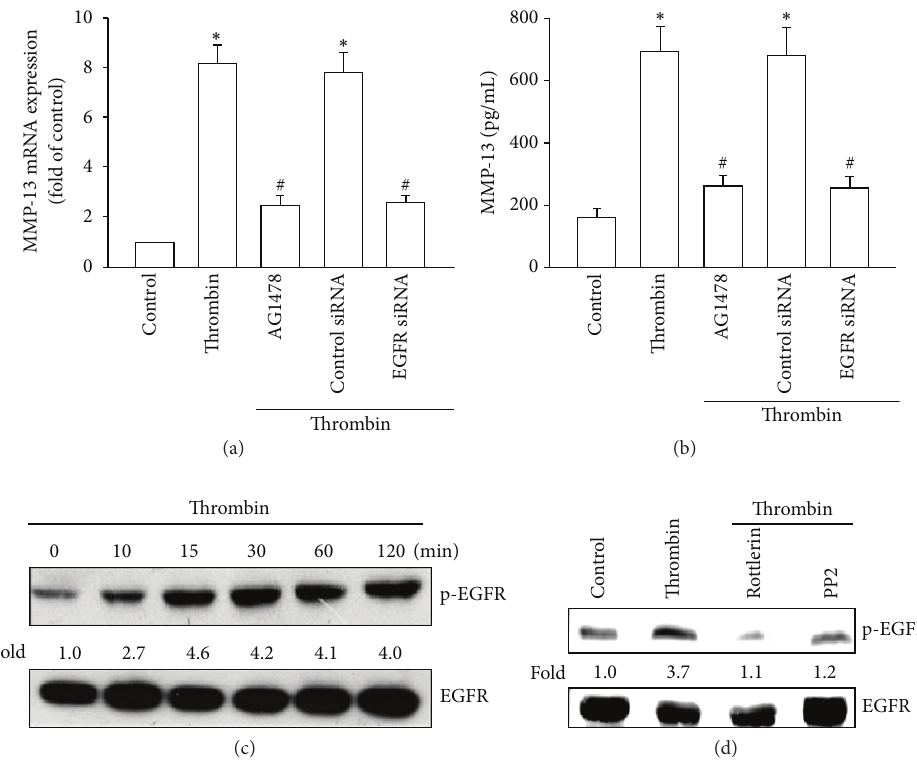
Figure 4: Thrombin-mediated EGFR transactivation in human chondrocytes. ((a) and (b)) qPCR and ELISA analyses of MMP-13 expression in chondrocytes, which were pretreated with AG1478 (1 𝜇 M) for 30 min or transfected with EGFR siRNA for 24 h and then stimulated with thrombin for 24h. (c) Western blotting analyses of EGFR phosphorylation in cells incubated with thrombin for the indicated time intervals. (d) Western blotting analyses of EGFR phosphorylation in chondrocytes pretreated with rottlerin or PP2 for 30 min and then stimulated with thrombin for 60min. ∗ 𝑃 < 0.05 as compared with basal levels. # 𝑃 < 0.05 as compared with the levels in the thrombin-treated